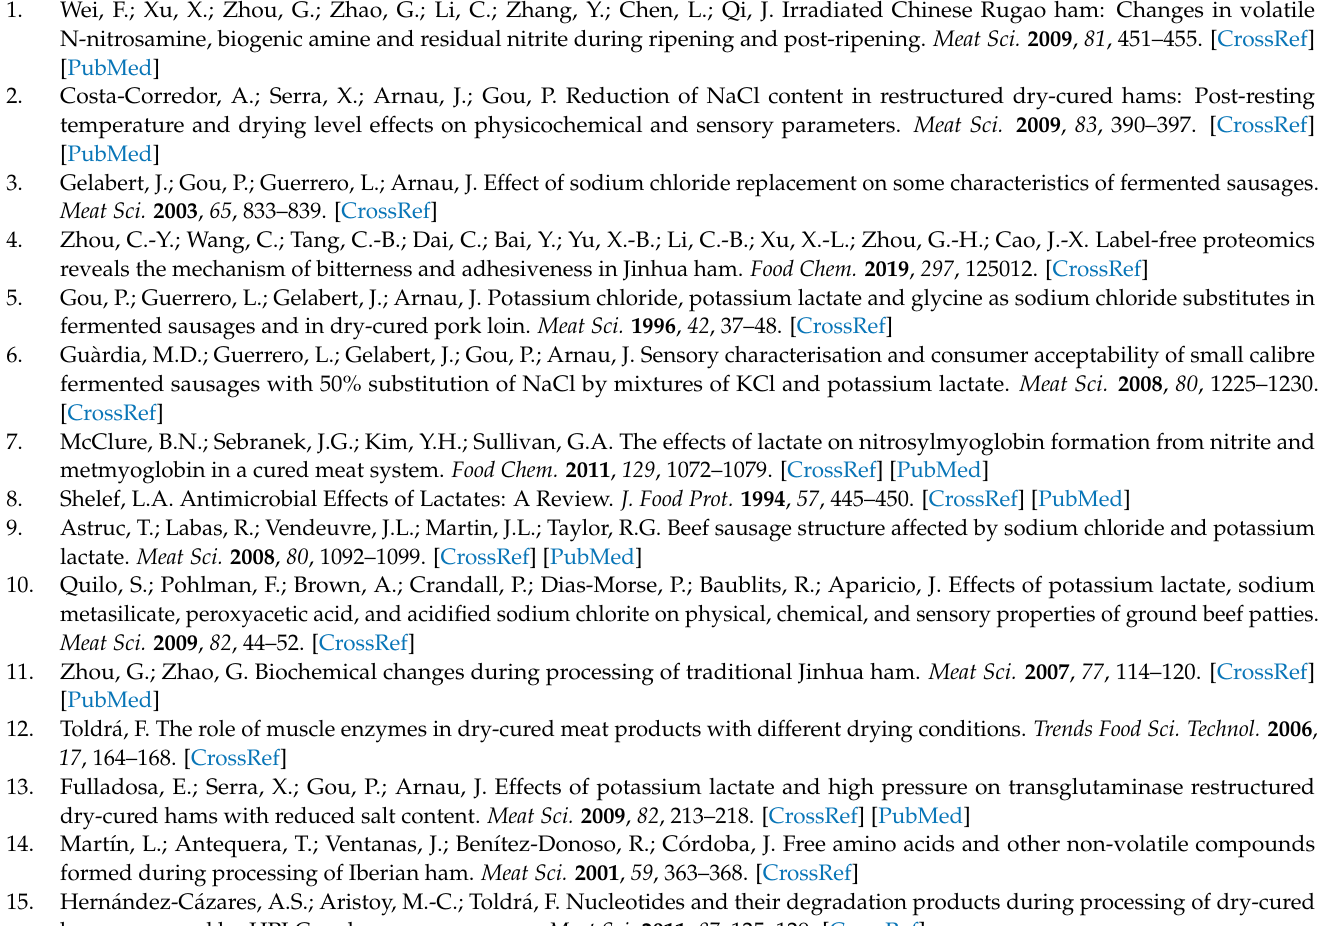
Table S1: Optical density of protein bands in the SDS-PAGE detected in Rugao hams; Table S2: Summary of identified and analyzed metabolites in Rugao ham samples and their numbers on 1 H NMR